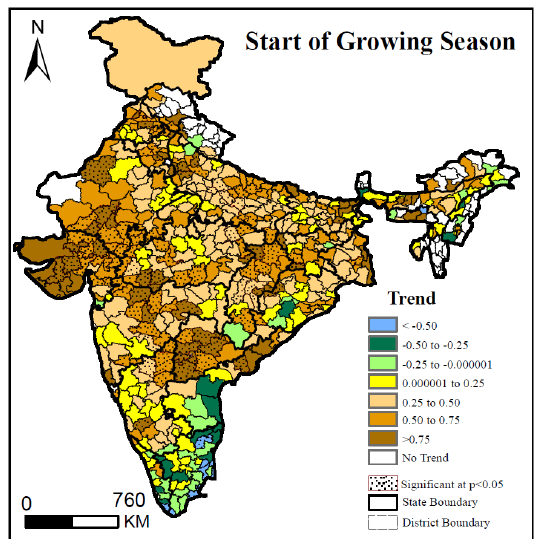
Figure 9 Trends of start of growing period for Kharif crop during 1982-